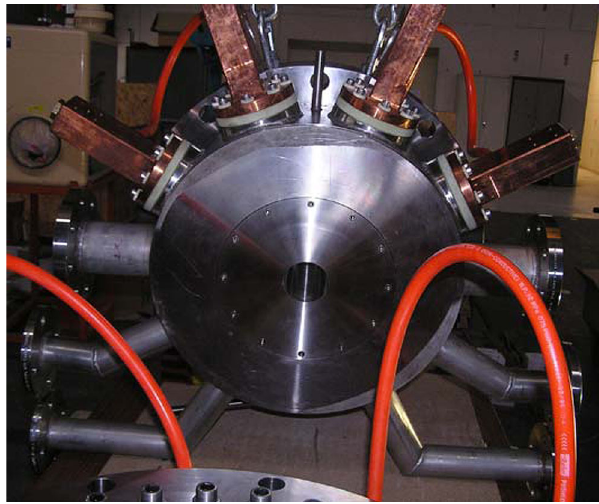
FIG. 18. The SEISM 60 GHz ECR source